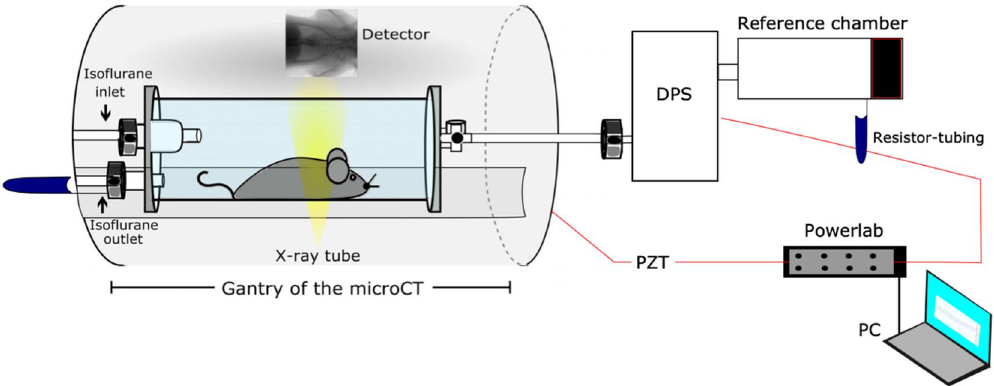
Figure 1. Schematic illustration of the set-up for correlative XLF, WBP and micro-CT measurements. One end of the WBP chamber has an isoflurane inlet/outlet, the other end is connected to the differential pressure sensor (DPS) which in turn is connected to a reference chamber, a Powerlab data acquisition device and a portable computer (PC). The chamber is placed inside the gantry of the micro-CT imaging system on the sample stage. The mouse is positioned inside the chamber such that the chest cavity is within the field of view (FOV). A piezoelectric (PZT) acoustic sensor that transduced the sound of the CT door interlock is used to synchronize data acquisition from WBP with XLF or